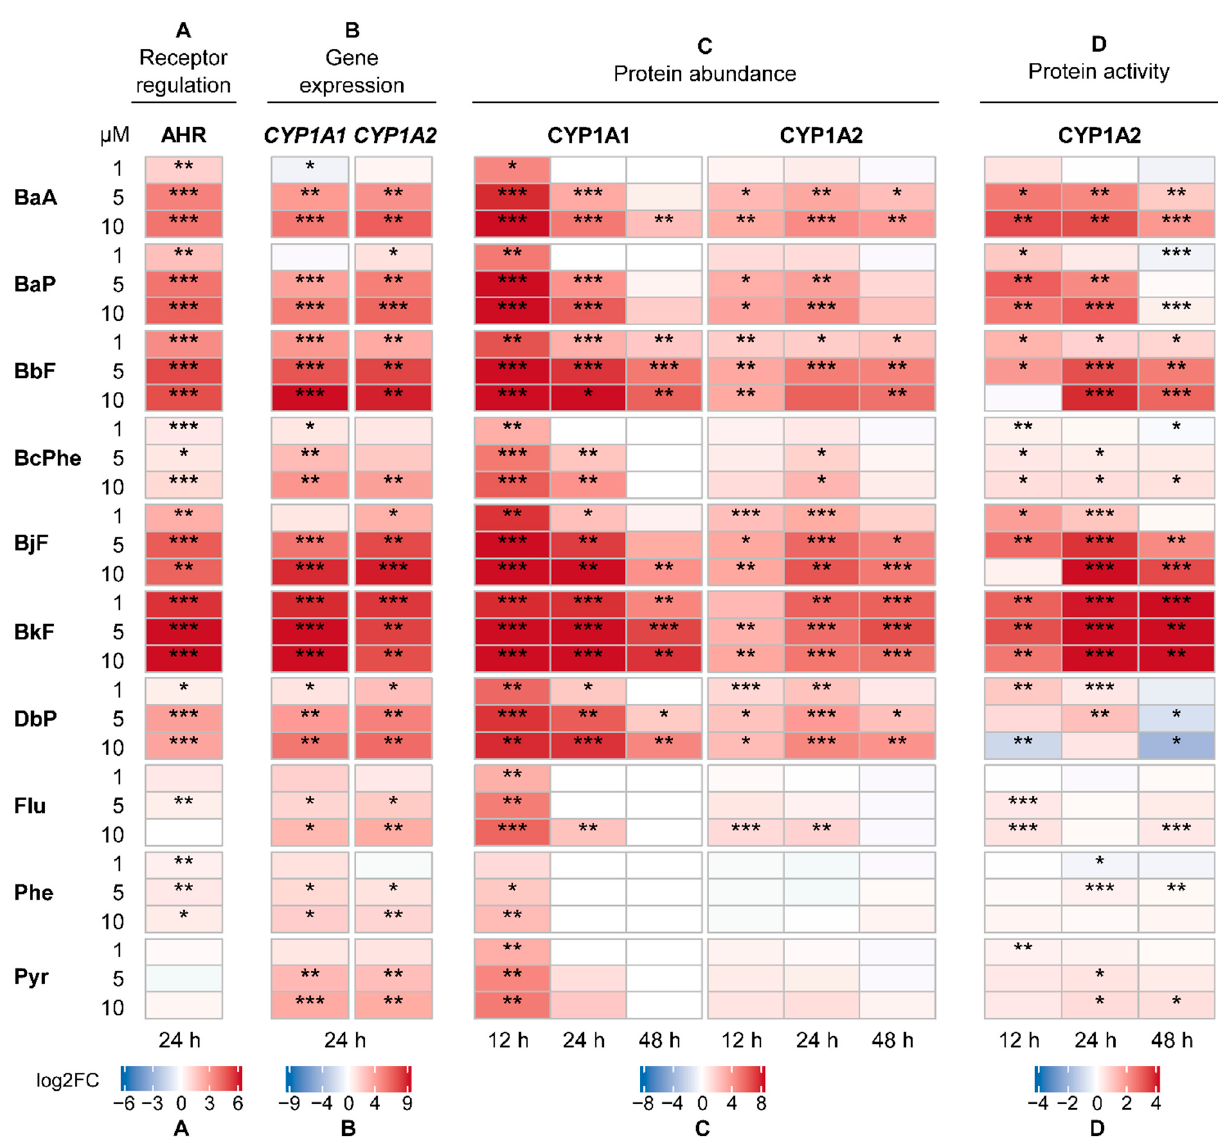
Figure 3. Cumulated heatmaps of receptor regulation ( A ), gene expression ( B ), protein abundance ( C ), and protein activity ( D ) of aryl hydrocarbon receptor (AHR) and its targets cytochrome P450 monooxygenase 1A1 (CYP1A1) and 1A2 (CYP1A2), respectively. Respective experiments were conducted as described in the Materials and Methods section. For protein abundance and activity, the following applied: For values below the respective lower limit of quantification (LLOQ), the value half of the LLOQ was used for calculations. Generally, mean values were calculated from the individually measured raw data. Fold changes with regard to the respective solvent control were determined and then log2-transformed (log2FC). A positive regulation is indicated by red shades, a negative regulation by blue shades. Statistical analysis was performed with Student’s t -test ( n = 3, * p ≤ 0.05, ** p ≤ 0.01, *** p ≤ 0.001). Underlying fold changes and standard deviations can be found in the Supplementary Materials “Underlying Data”.